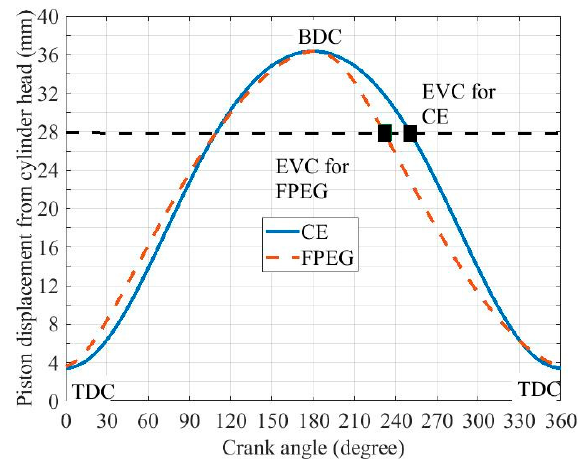
Figure 5. Valve timing of CE and FPEG with port scavenging type.